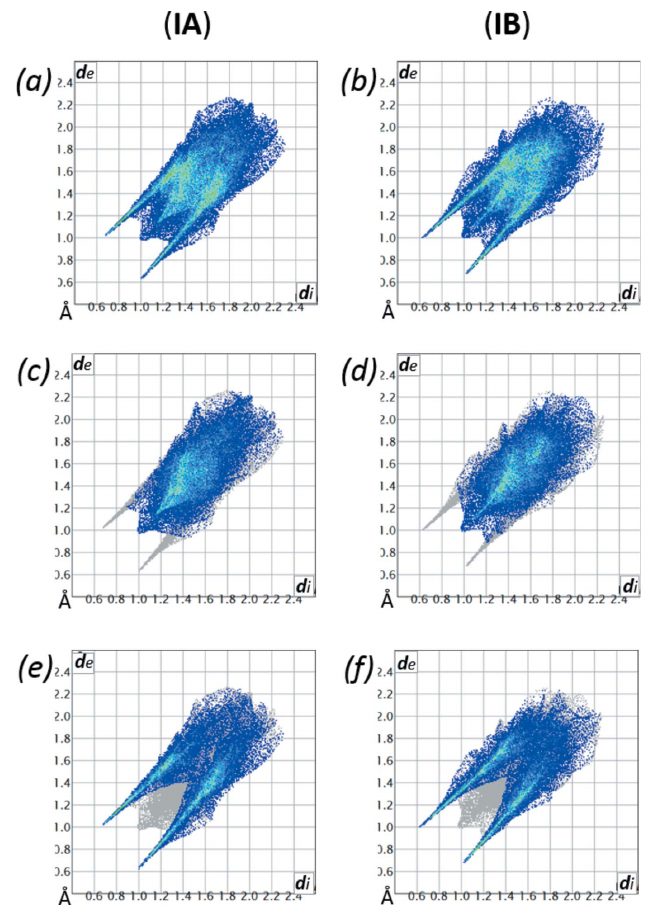
Figure 6 Two-dimensional fingerprint plots produced for the Hirshfeld surfaces of (I A ) and (I B ). The full plots for (I A ) and (I B ) are shown in ( a ) and ( b ), respectively. Contributions to the plots from the H (cid:5)(cid:5)(cid:5) H contacts are shown in ( c ) and ( d ) and the contributions from the O (cid:5)(cid:5)(cid:5) H/H (cid:5)(cid:5)(cid:5) O contacts are depicted in ( e ) and ( f ).